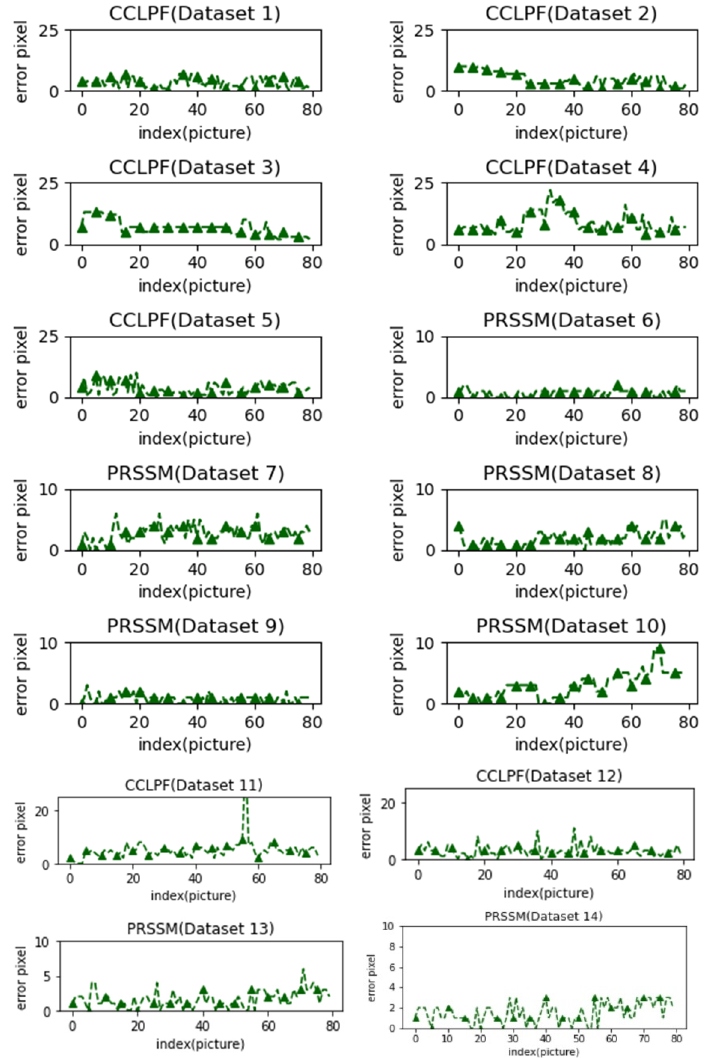
Figure 56. Pupil diameter errors for the PRSSM and CCLPF algorithms for the 10 data sets.